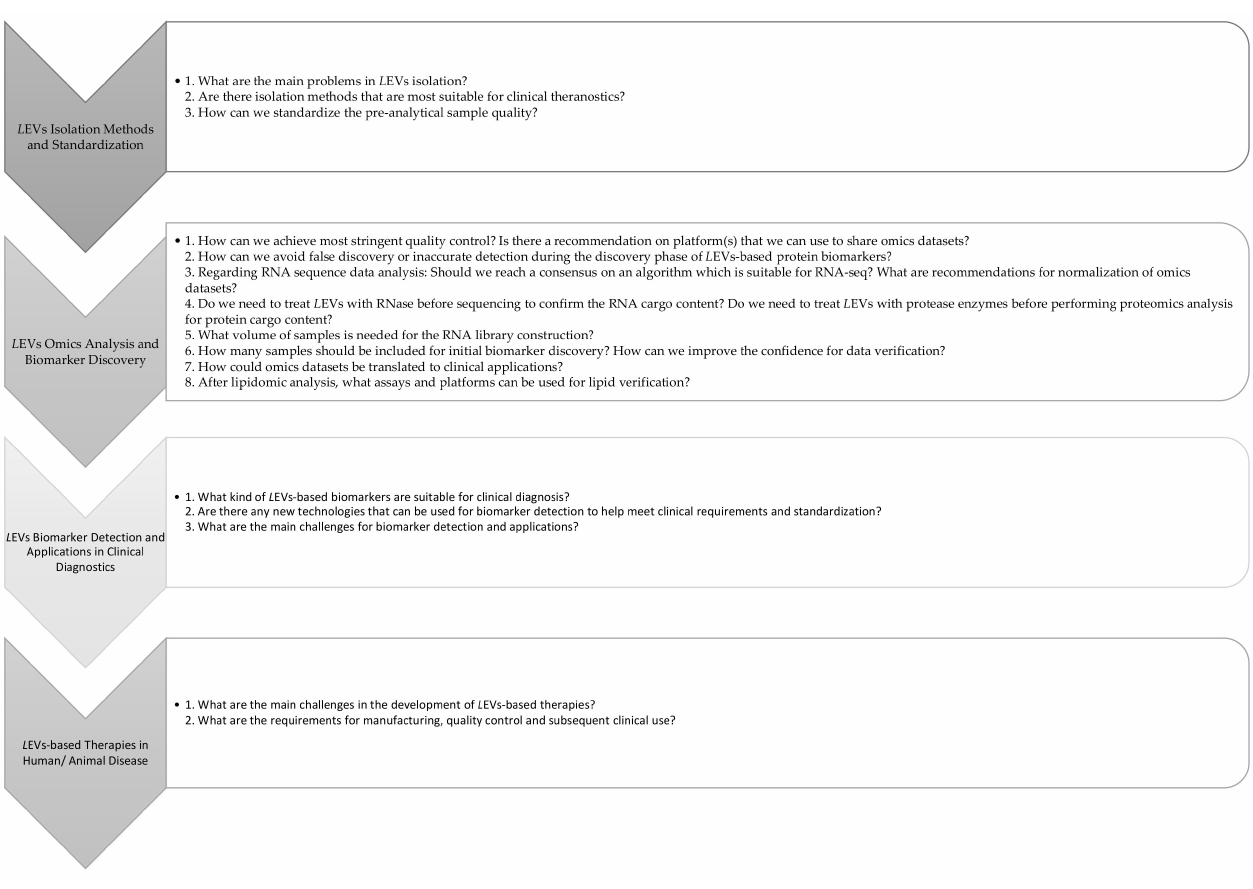
Figure 6. Guided reading questions for Leishmania extracellular vesicles research